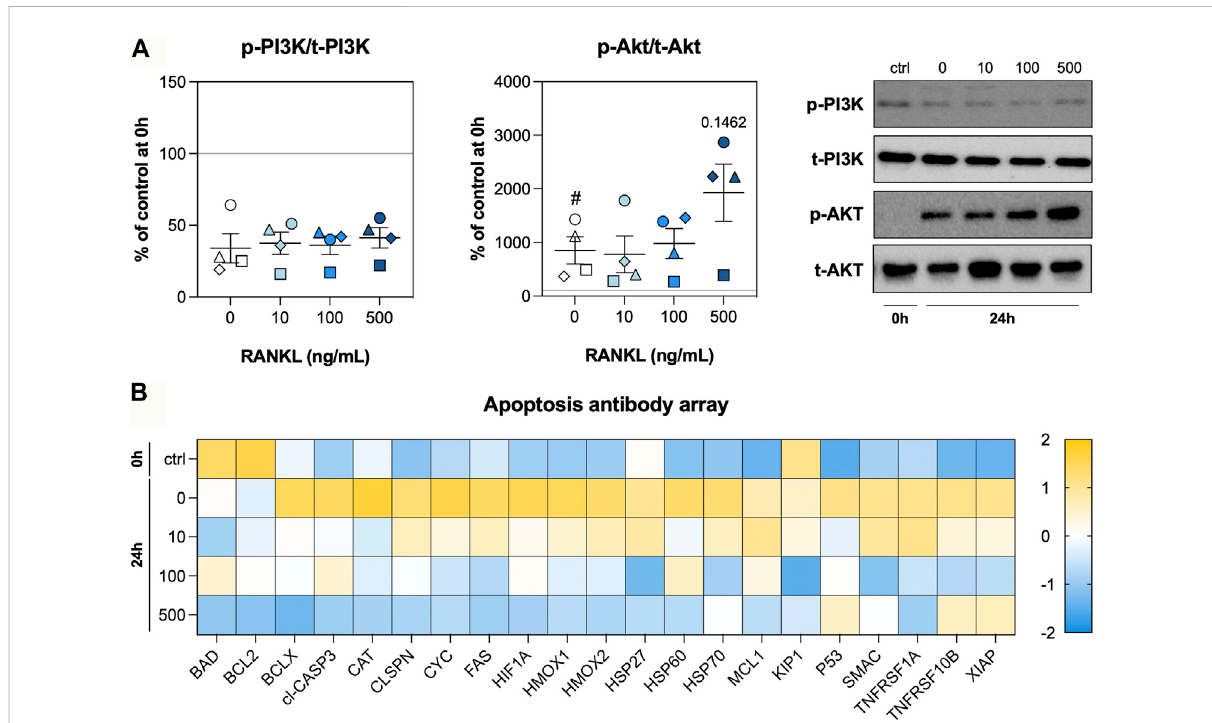
FIGURE 5 PI3K/Akt signaling and apoptosis. Slices were sampled after slicing (0 h) and after 24 h of incubation without or with 10, 100, or 500 ng/ml RANKL( n =4).ThephosphorylationofPI3KandAkt (A) wasanalyzedtodeterminewhetherthetissueadoptedapro-survivalphenotype.Wepro fi led apoptosis-related proteins (B) to obtain more information about stressors and effectors (row z-score). Values represent individual experiments performedintriplicateandareaccompaniedwiththearithmeticmean(horizontalline)±standarderrorofthemean(errorbars).( # indicates p < 0.05 between untreated slices at 0 and 24